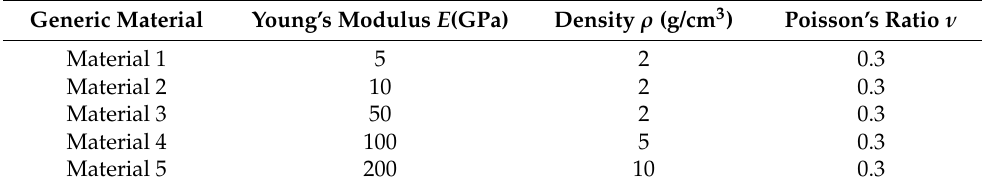
Table 2. Mechanical properties of the crown materials. Table 3. Young’s moduli and densities explored in this